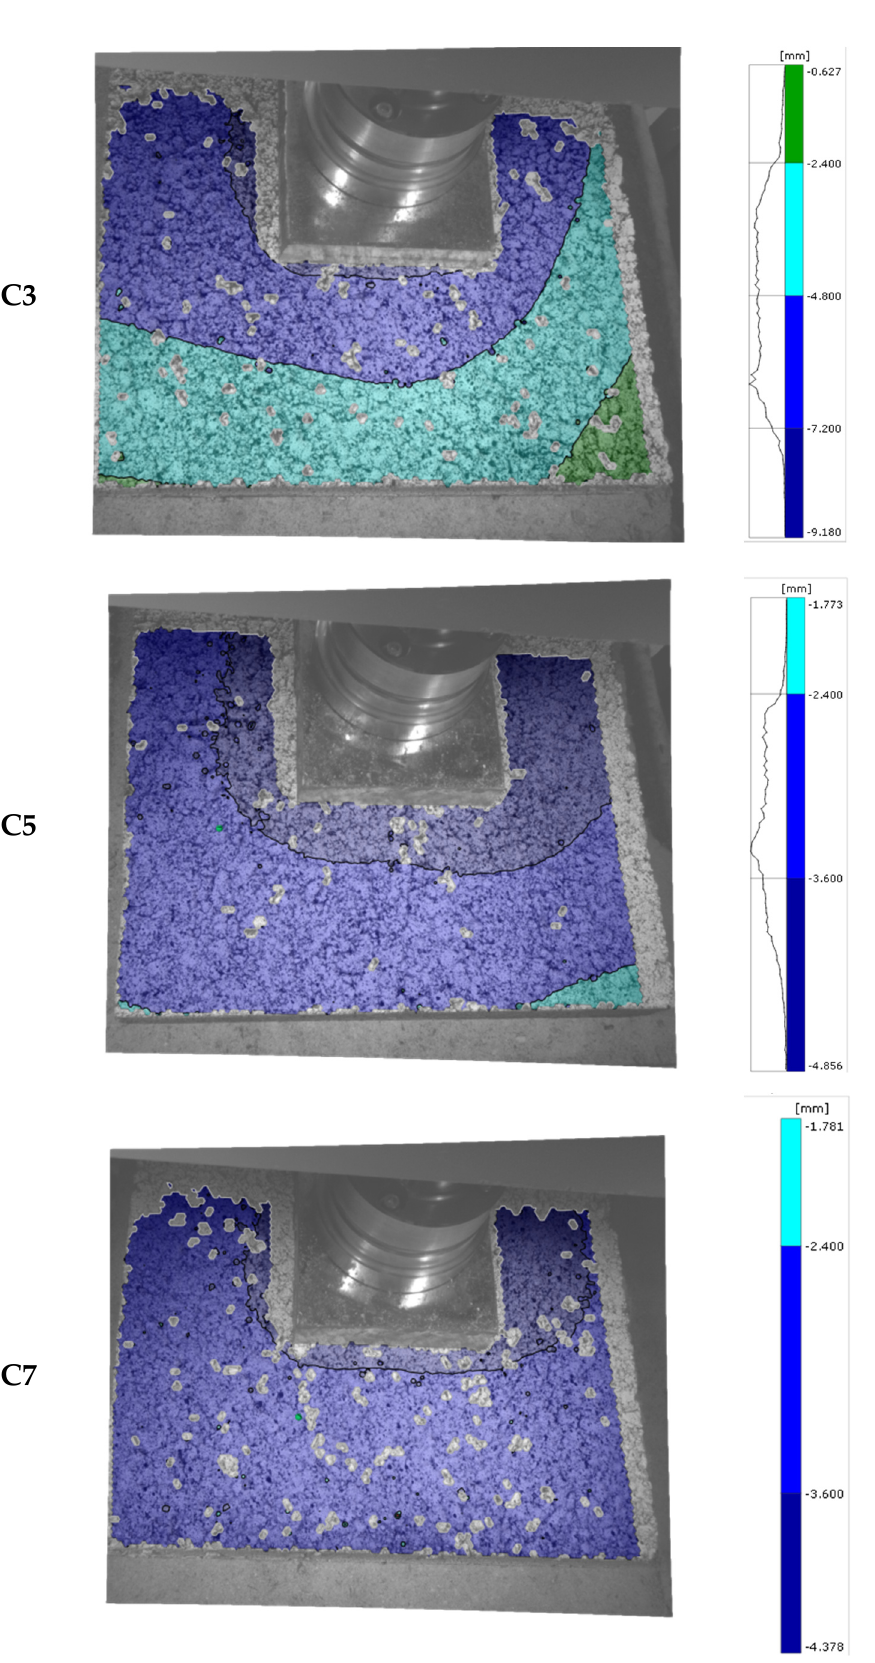
Figure 8. Displacement fields at the end of the 4th loading cycle for samples with various levels of cement.